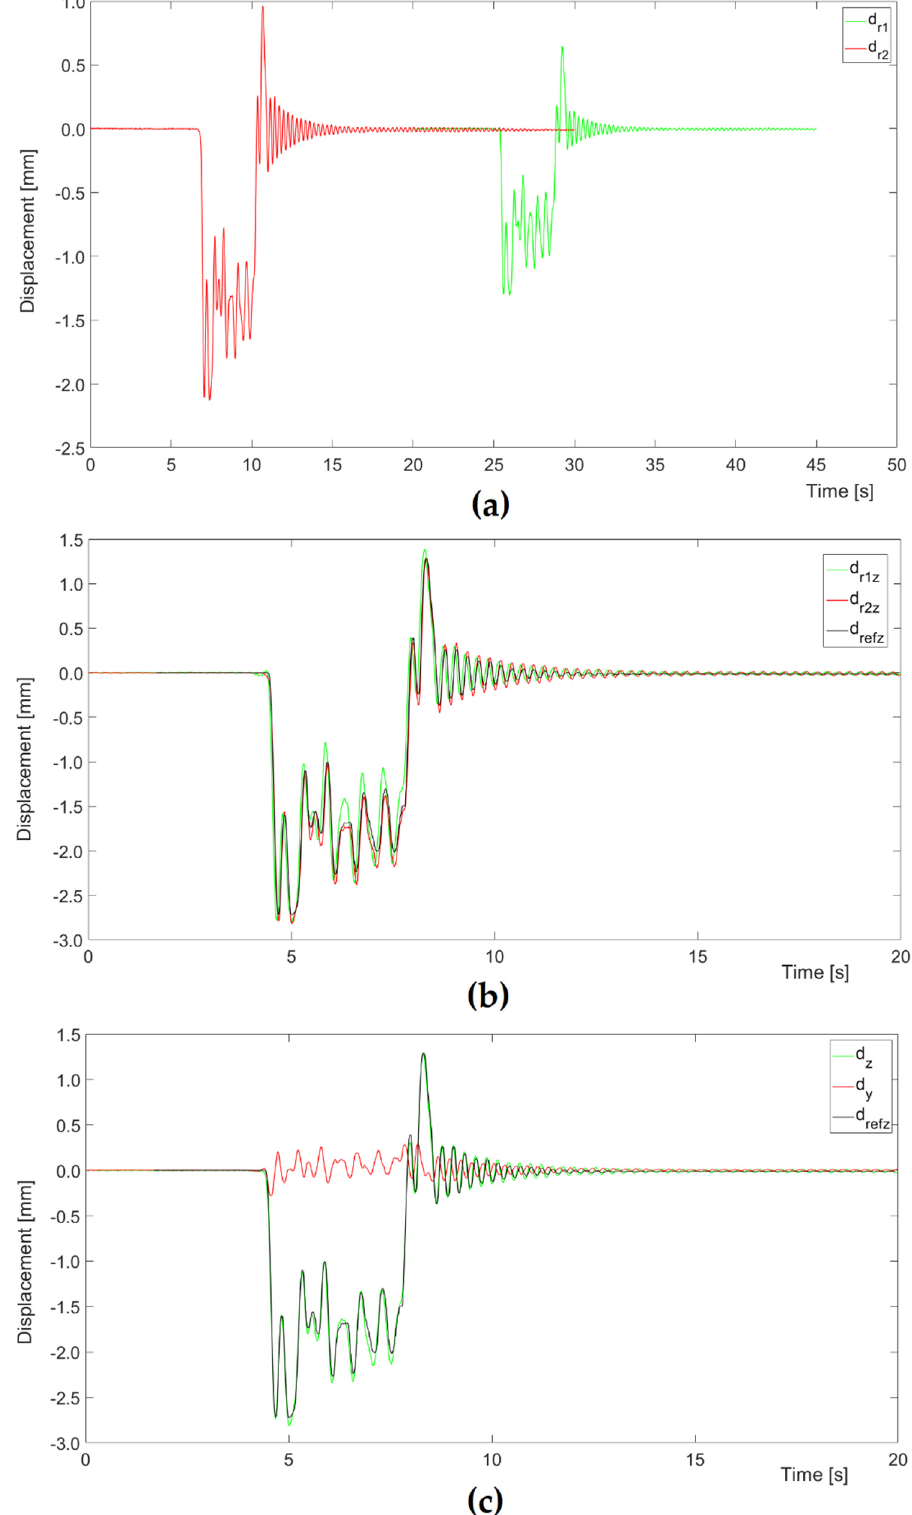
Figure 12. Bridge No. 2—an example of an analysis of a multiple-unit passenger train passage: ( a ) displacements in the range direction measured by single radars No. 1 and No. 2 before synchronization; ( b ) vertical displacement measured by single radars No. 1 and No. 2 and the reference vertical displacement measurement; ( c ) vertical and horizontal displacement calculated based on two radars’ (No. 1 and No. 2) measurements and the reference vertical displacement measurement.